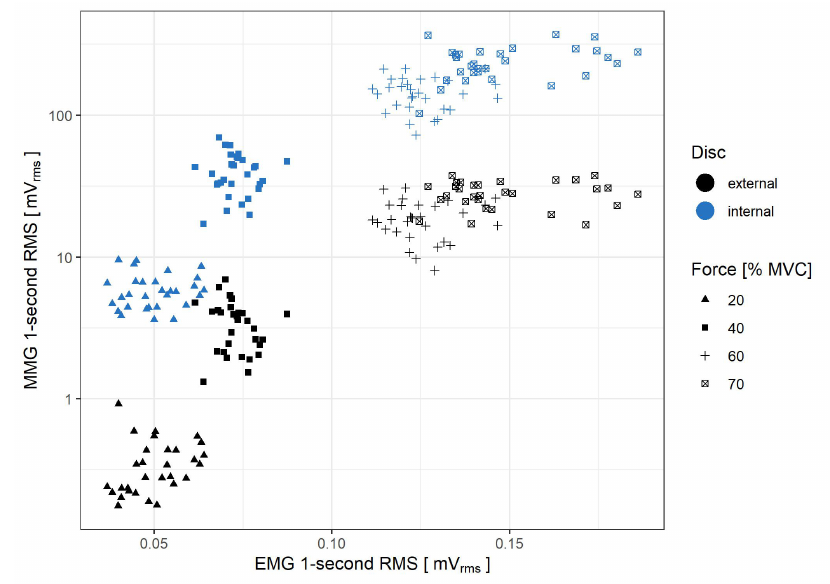
Figure 8. Comparison of MMG and EMG RMS values obtained during step isometric contraction measurement. The 0% MVC level is omitted, as it does not reflect muscle activity. The comparison is made for both internal (blue) and external (black) piezoelectric discs. In Figure 9 the relationship between EMG and MMG recorded from both external and internal piezoelectric discs during ramp isometric contraction is